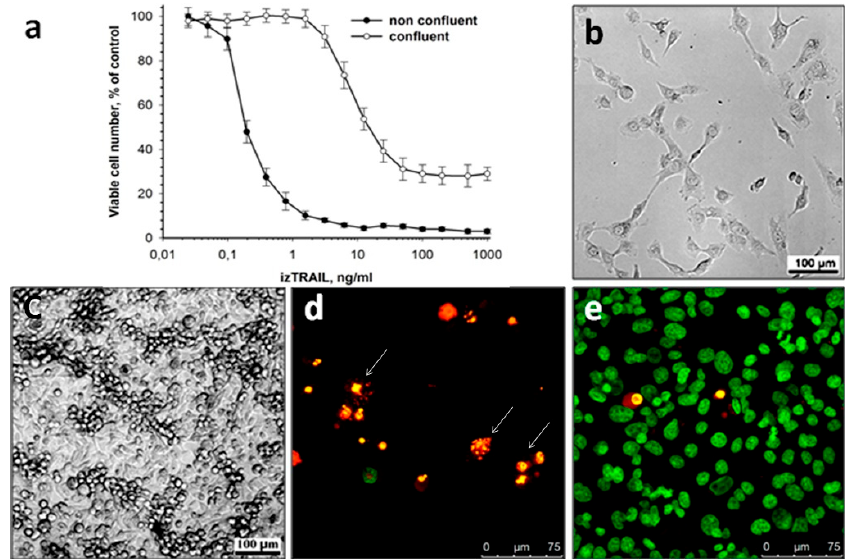
Figure 1. Increase in the resistance of HT-1080 cells to the recombinant protein izTRAIL in a confluent culture. ( a ) Cell viability vs. izTRAIL concentration in nonconfluent (24 h after seeding) and confluent (96 h after seeding) cultures, n = 5; ( b , c ) representative images of nonconfluent and confluent cultures, correspondingly; ( d , e ) representative images of nonconfluent and confluent cultures, correspondingly, in one day after the addition of 1.5 ng/mL of izTRAIL. The cultures were stained with cell nuclear dyes H33342 and PI, 1 µg/mL each. Green nuclei—viable cells, yellow-red nuclei—dead cells. Aberrant allocation of chromatin (arrow) indicates apoptosis.